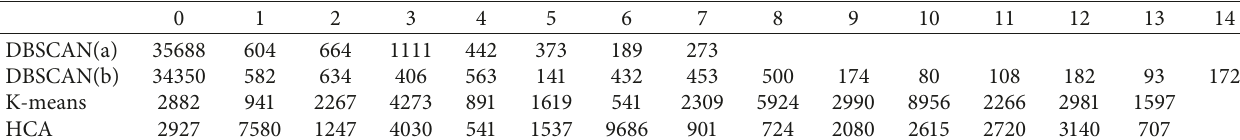
Table 1: Sample amount in different